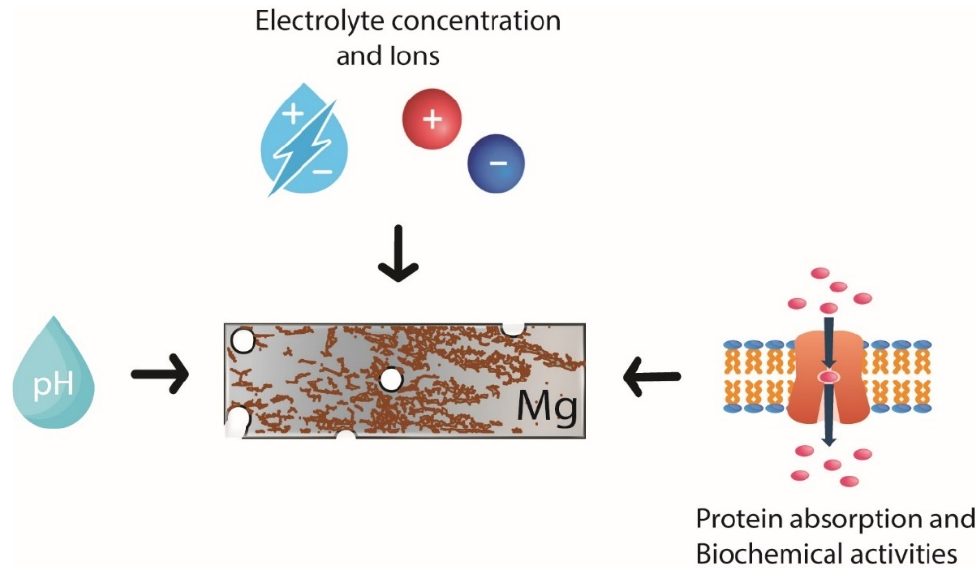
Figure 1. Influencing factors on Mg corrosion.